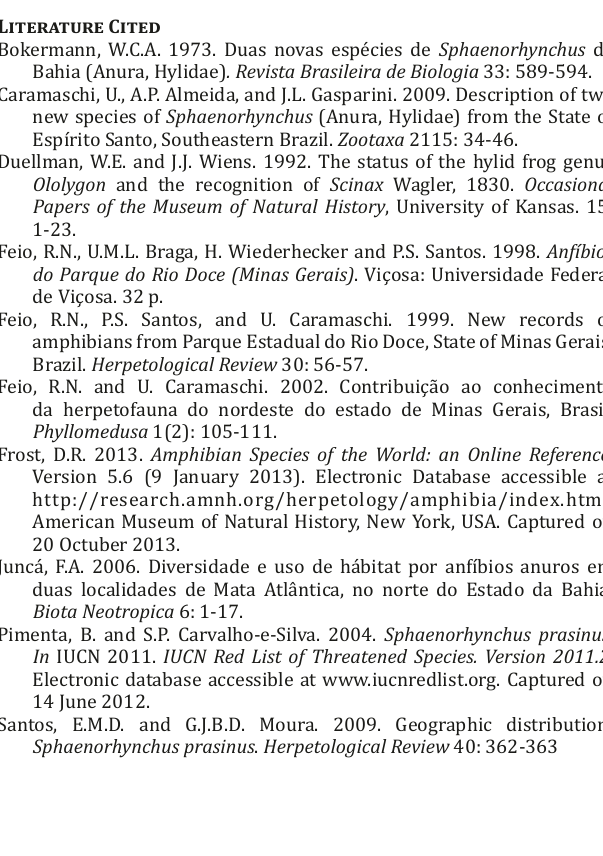
Sphaenorhynchus prasinus Figure 2. Map showing the new record of . Red circle: new record in Reserva Biológica de Pedra Talhada, Municipality of Quebrangulo., Alagoas. White circles: Municipality of São Lourenço da Mata, Pernambuco, and Municipality of Mata de São João,